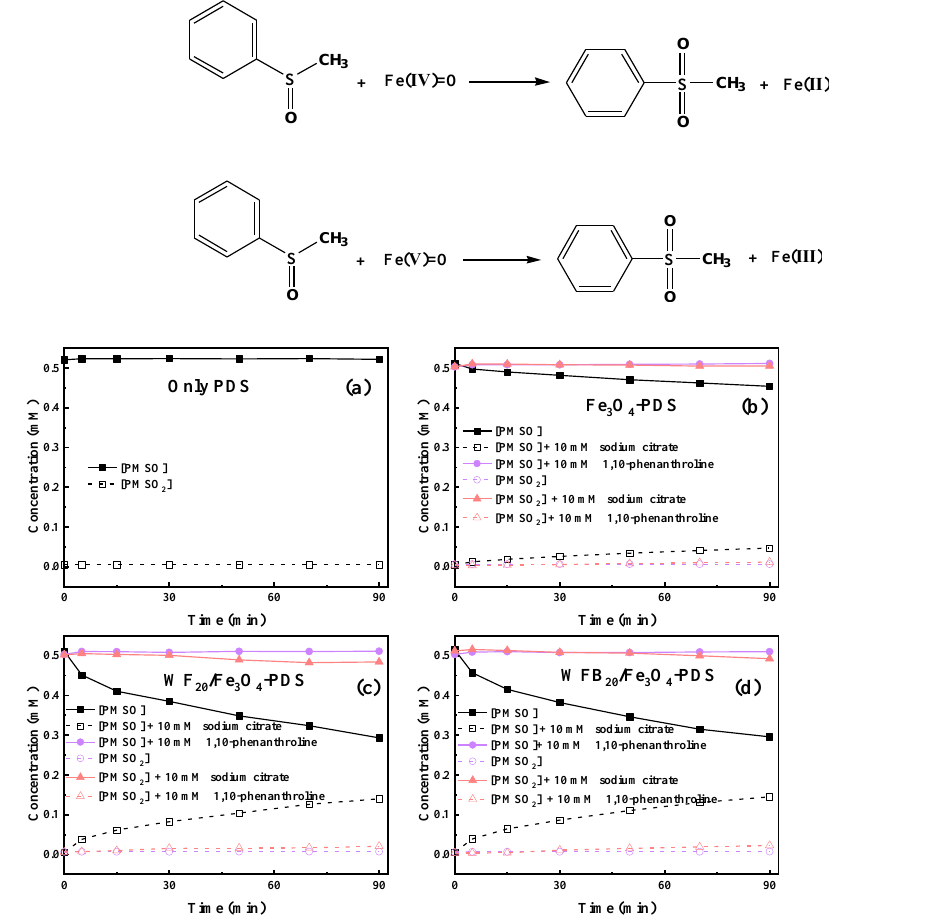
Figure 7. PMSO degradation and PMSO 2 production in the ( a ) PDS, ( b ) Fe 3 O 4 -PDS, ( c ) WF 20 /Fe 3 O 4 - PDS, and ( d ) WFB 20 /Fe 3 O 4 -PDS systems (conditions: catalyst 1.0 g/L, [PDS] 0 = 5.0 mM, [PMSO] 0 = 0.5 mM, pH 0 = 3.00 ± 0.1).